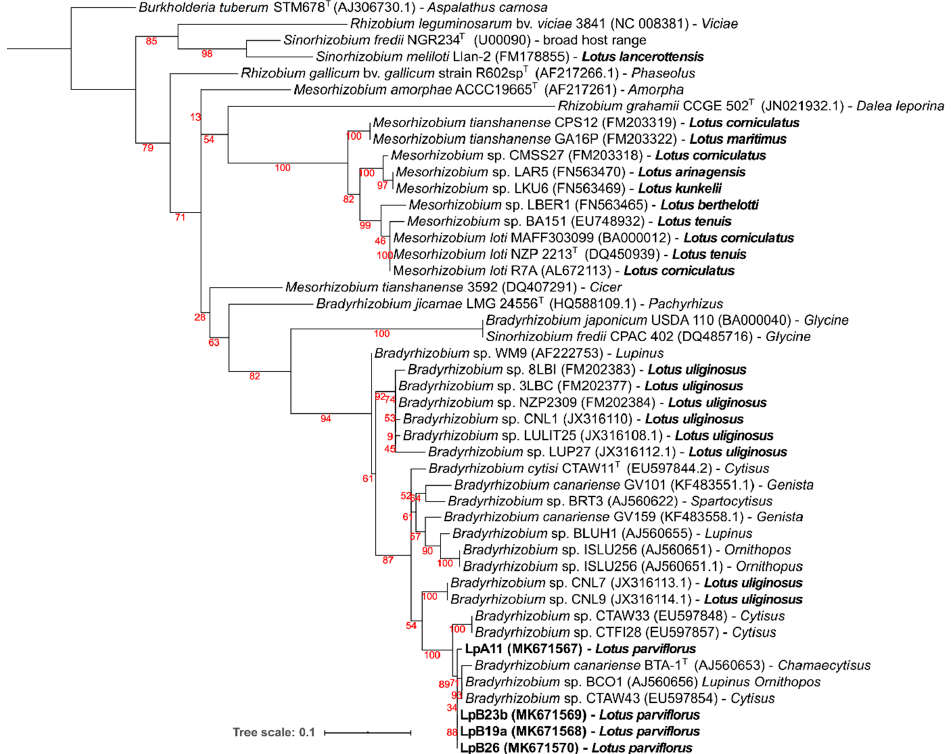
Figure 4. Phylogenetic tree of nod C gene sequences. Analyses were conducted with IQ-tree using Maximum Likelihood (ML) and ModelFinder (Best model: HKY+F+G4) methods), for a total of 203 positions. Bootstrap values are shown in red at each node. NCBI Genebank accession codes and original legume host of isolation are indicated. Burkholderia tuberum STM678 T (AJ306730.1), a bacterium from the beta-proteobacteria class that nodulates Aspalathus carnosa , was selected as an outgroup. Lotus spp. and isolates obtained from L. parviflorus nodules are in bold.